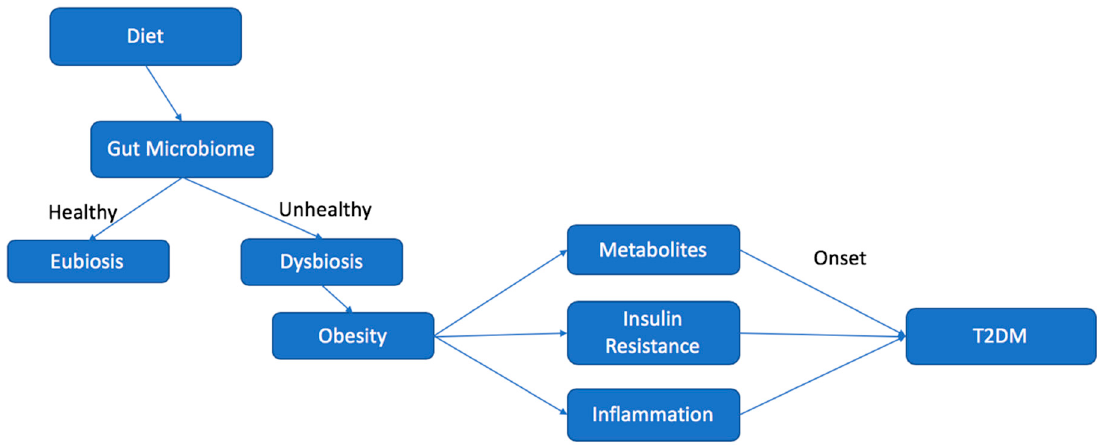
Figure 2. Chart illustrating the effect of diet on the microbiome and the relationship leading to increased risk for the development of type 2 diabetes mellitus (T2DM).